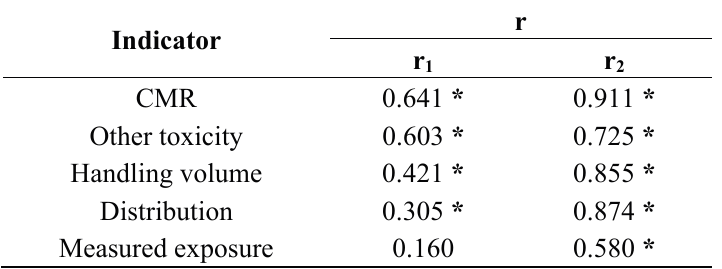
Table 6. Correlation coefficients (r) from a linear regression analysis of indicator scores and total